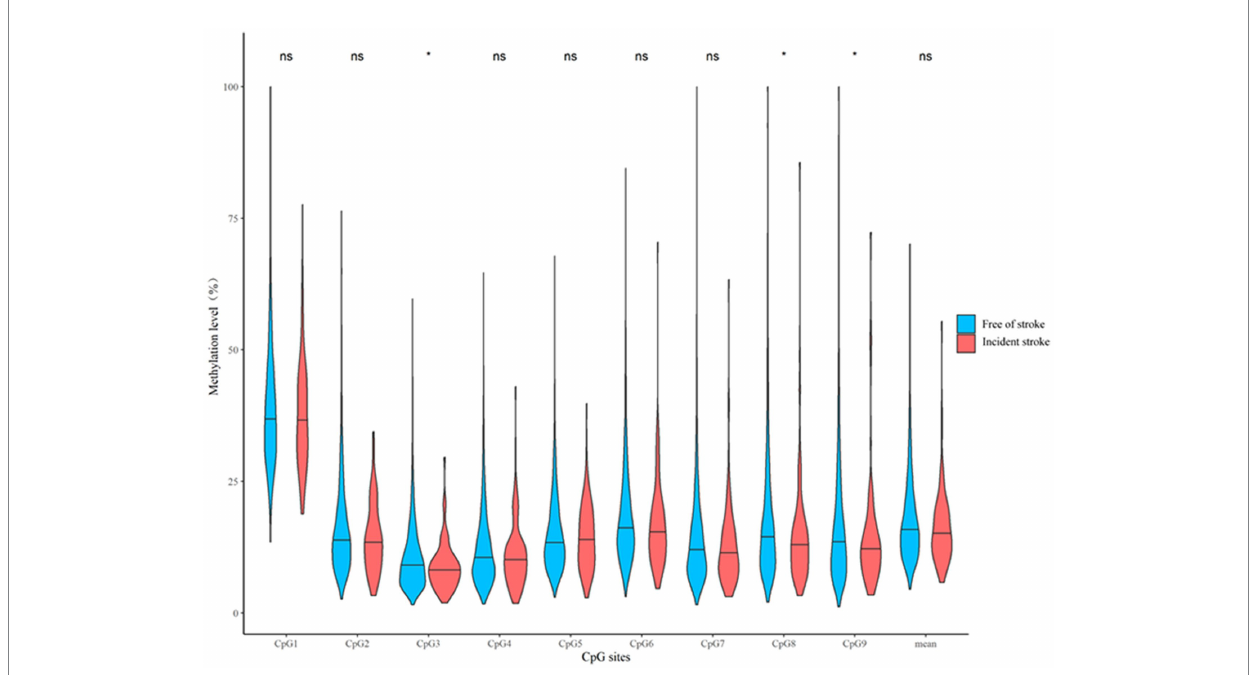
FIGURE 4 A box plot showing the individual and average DNA methylation levels of CpG sites in the CORIN promoter region according to the status of incident stroke in the replication sample. * p < 0.05; ns: p >